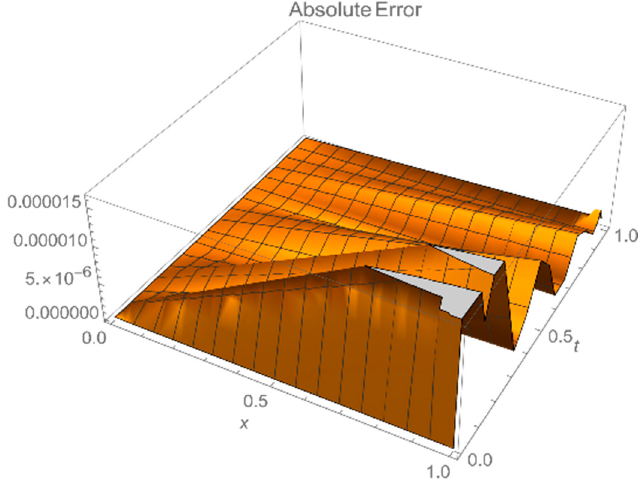
Figure 6. A 3D plot of the absolute error between approximate and exact solutions of Example 4 with n = 9-degree of B-polys is shown in both variables ( x , t ). The approximate solution has not converged as we need to increase the number of B-poly in variable t for better accuracy in the solution.